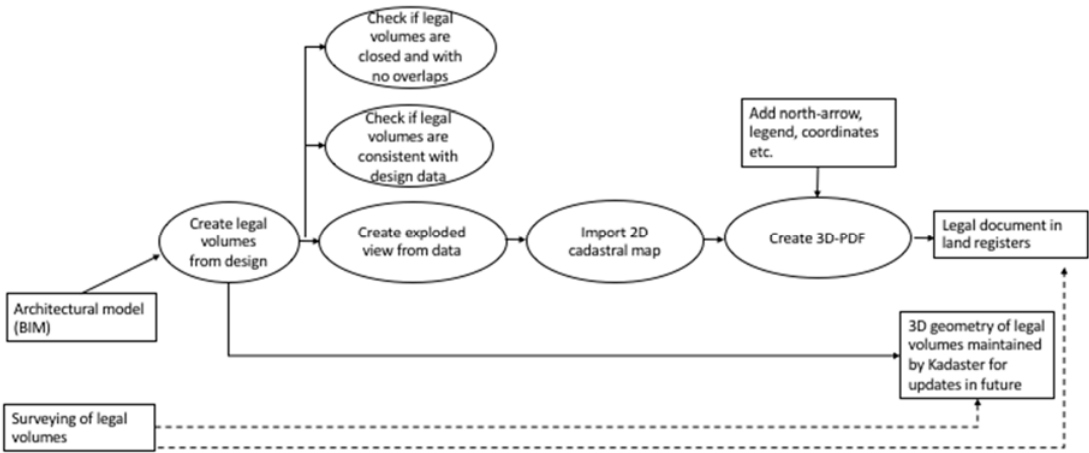
Figure 10. Schematic overview of a workflow to create a 3D PDF visualising a multi-property situation